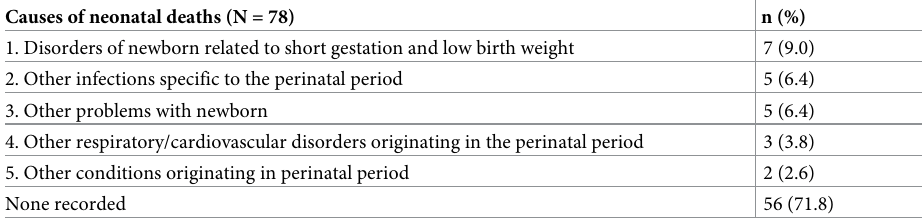
Table 4. Top five causes of neonatal death identified using PN RAPID in two facilities in Nepal. Causes of neonatal deaths (N =